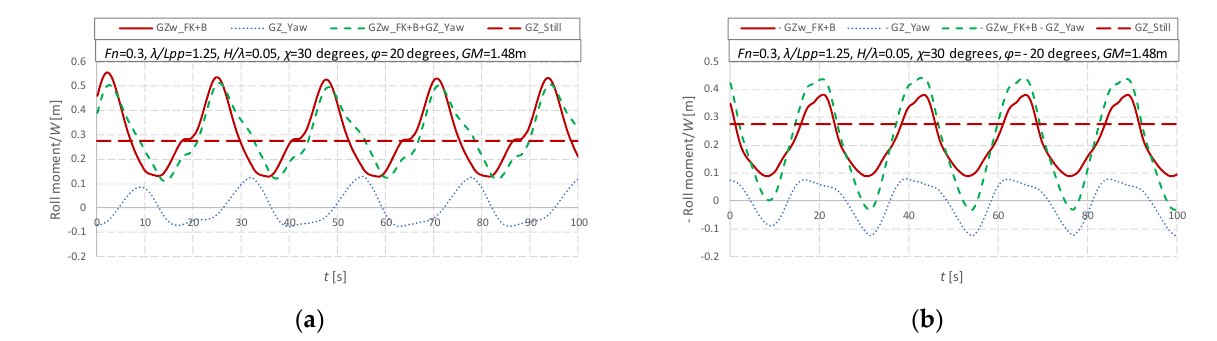
Figure 8. Comparison between the roll-restoring arms and the coupled yaw forces in the rolling